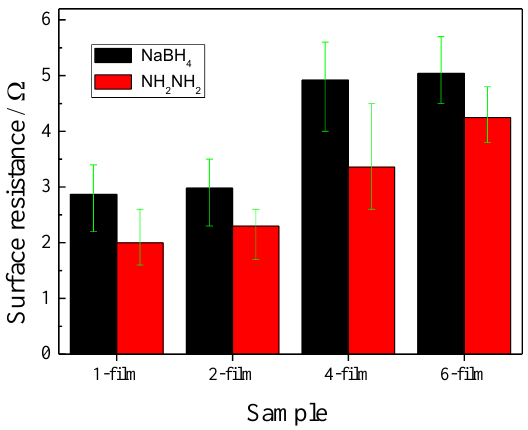
Figure 4. Surface resistances of the IPMCs with various thicknesses.